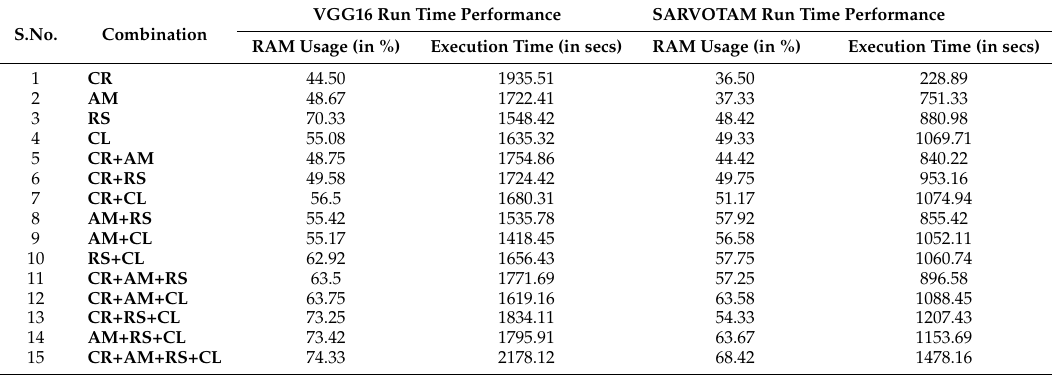
Table 9. Recorded RAM utilization and execution time for SARVOTAM and VGG16 while classifying Android malware